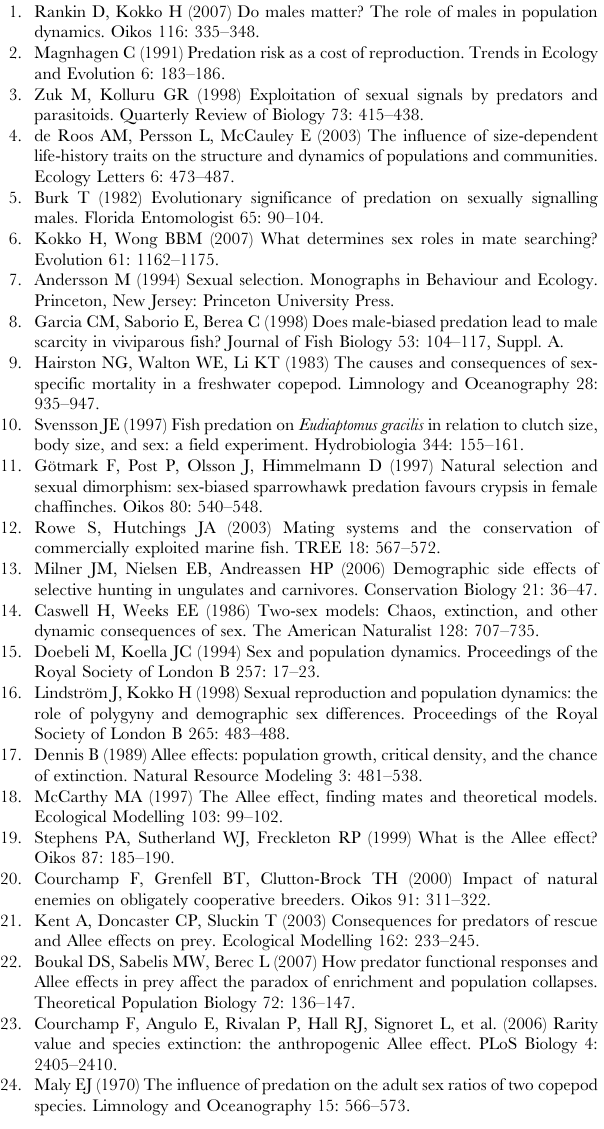
Figure S4 Stability of model (S3) in Text S2 with unlimited polygyny and no mate-finding Allee effect. Combined effect of predation bias and handling time of the predator with Holling type II functional response. Other parameters: b =3, d = 0.2, H = 0, e 1 =0.2, e 2 = 0.1, and M = 1. E 2 is locally stable within the grey area. Areas I and II delimited by line L = 1 refer to Table 2 in the main text. Found at: doi:10.1371/journal.pone.0002687.s007 (0.93 MB